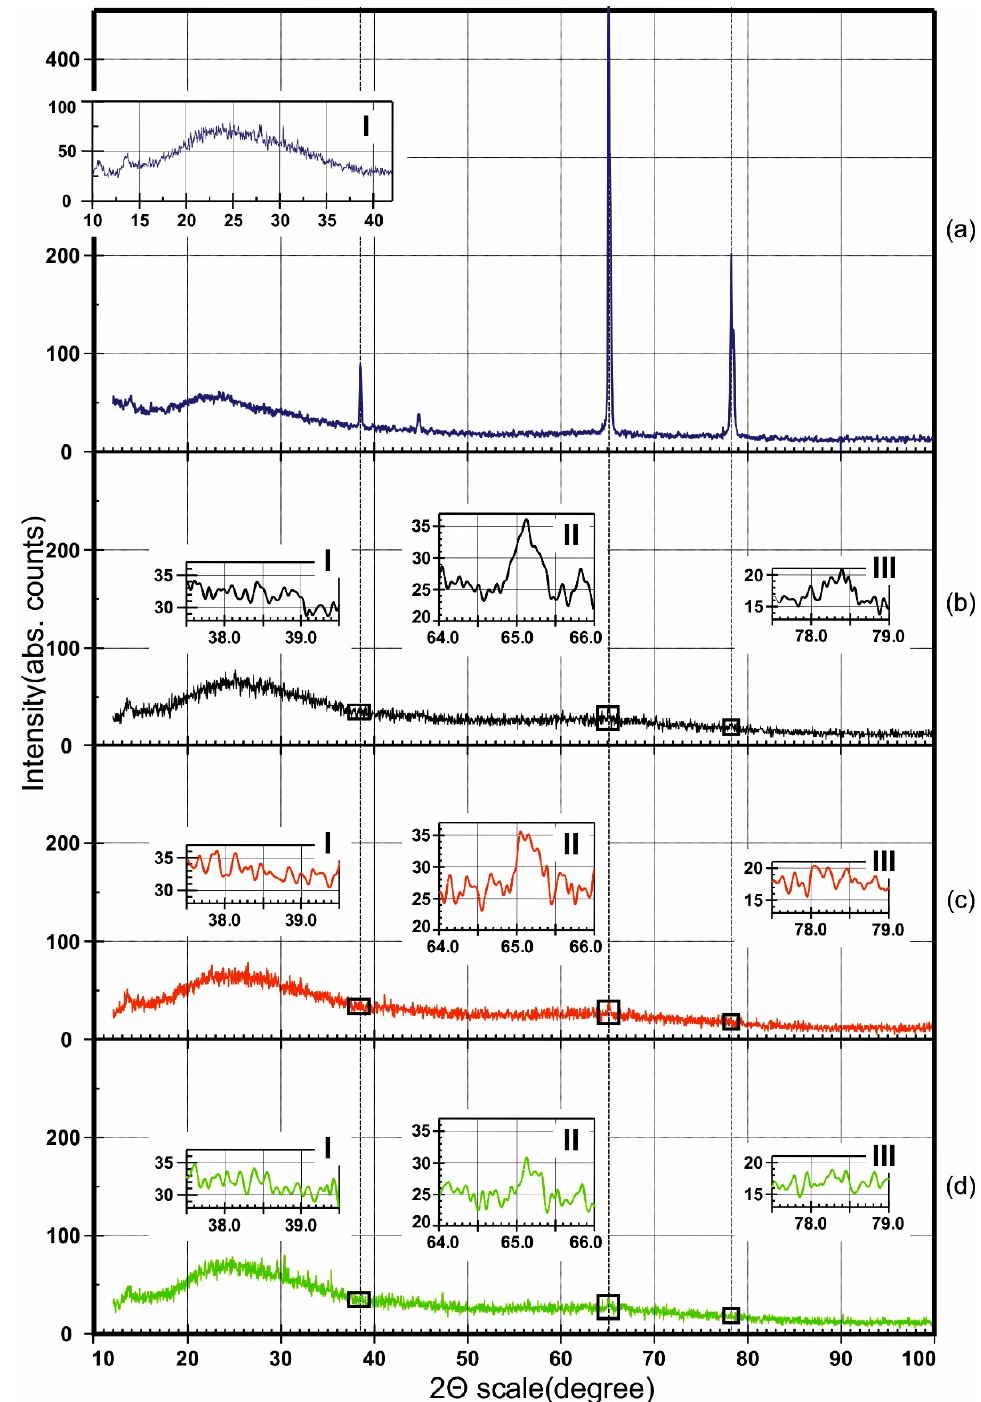
Figure 7. XRD patterns of ( a ) initial aluminum and porous alumina films obtained in ( b ) 0.4, ( c ) 1.0, and ( d ) 2.0 M sulfuric acid solutions, at 4.25, 4.05, and 6.10 mA ∙ cm − 2 current densities, respec ‐ tively.